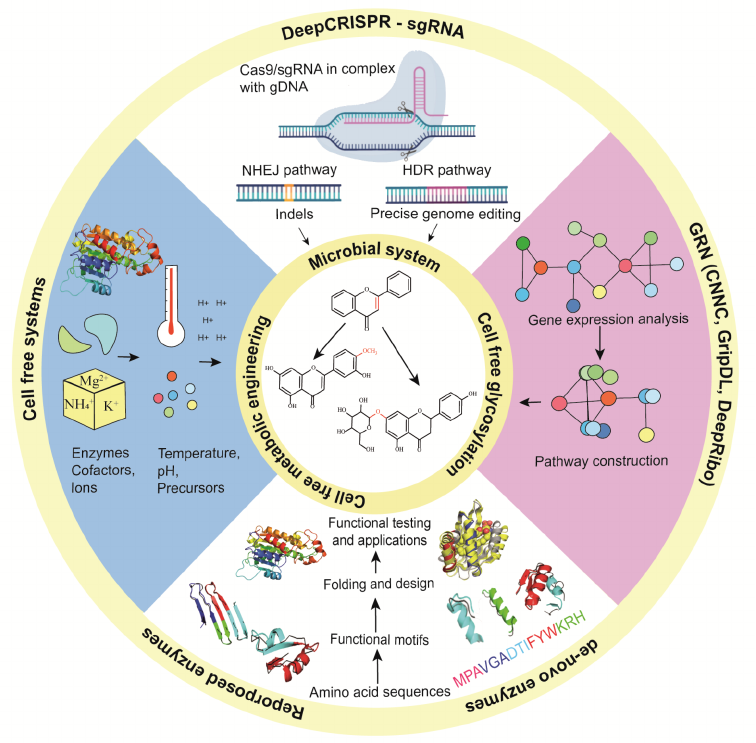
Figure 4. Microbial systems, cell-free systems and cell-free glycosylation approaches are used to synthesize flavonoids with an improved PK profile. To produce commercially viable titer, rate and yield (TRY), machine-learning approaches like DeepCRISPR and sgRNA can help in the genetic engineering of microbial systems and gene regulatory network (GRN) analysis tools can help in the construction of new metabolic pathways. Similarly, protein engineering approaches can also help flavonoid biosynthesis through reproposing enzymes for better activity and stability, as well as by de novo synthesis of enzymes for the production of new-to-nature flavonoid derivatives. Abbreviations: CNNC; convolutional neural network for coexpression, GripDL; gene regulatory interaction prediction via deep learning, NHEJ; non-homologous end joining, HDR; homology directed